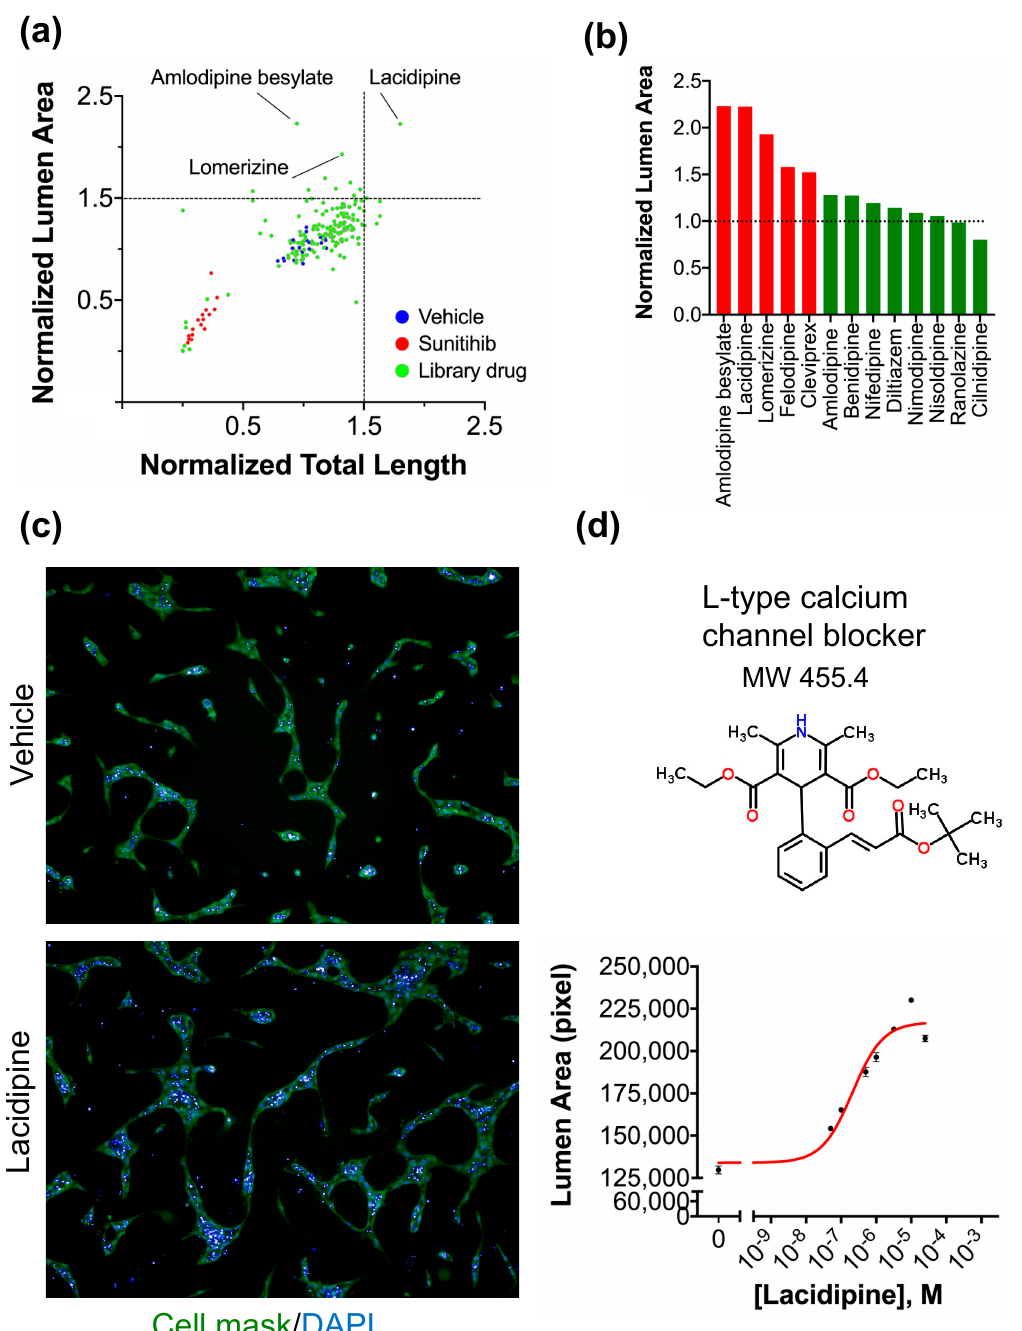
Figure 2. High-content screening of the cardiovascular compound library using the angiogenesis assay and hit identification. ( a ) Scatter-plot distribution showing the results of high-content screening. The lumen area and the total tube length were normalized to controls treated with vehicle (DMSO). Enhancer hits of the lumen area are indicated below and above the dotted lines (hit threshold was calculated as follows: median (vehicle) + 4 × standard deviation (vehicle) ). Negative controls (are shown in blue positive controls in red and drug library molecules in green. ( b ) Calcium blockers (in red) were identified as enhancers of lumen formation from the library. ( c ) Representative fluorescent images from negative control (vehicle) and Lacidipine (enhancer hit for lumen area). Scale bar = 100 µ m. ( d ) Dose–response curve demonstrating the effect of Lacidipine on lumen size using the angiogenesis assay. Data are expressed as mean ± SEM. n = 3 per concentration. The EC 50 was calculated as 250